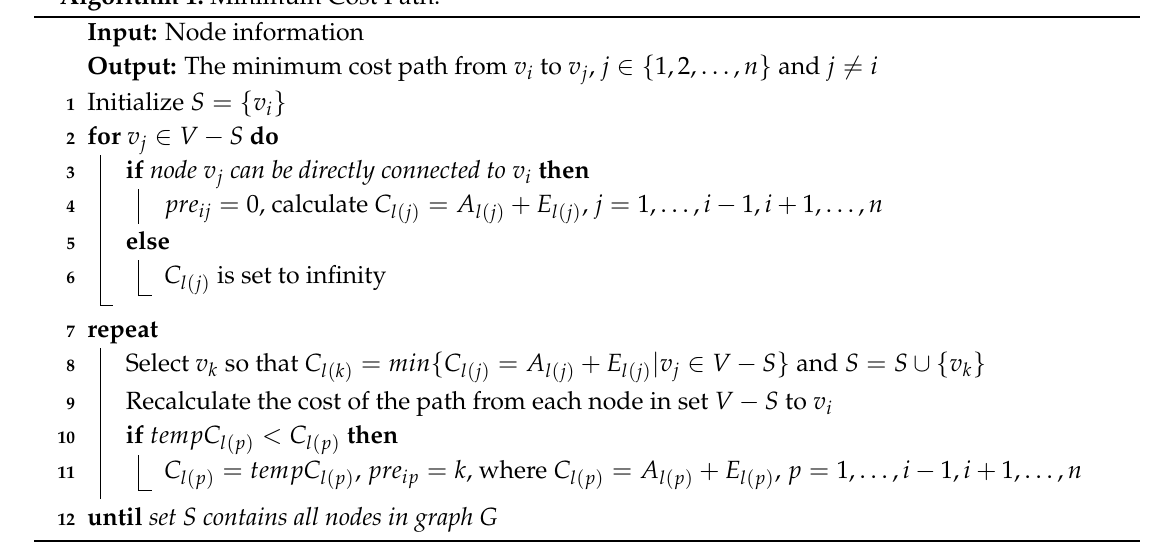
Algorithm 1: Minimum Cost Path.